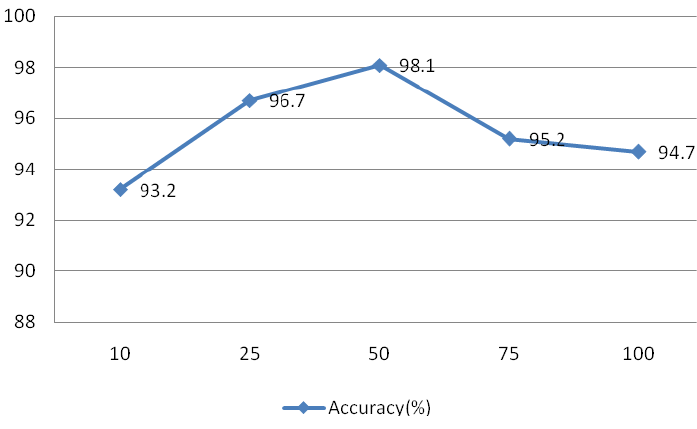
Figure 25. Comparison of different length of